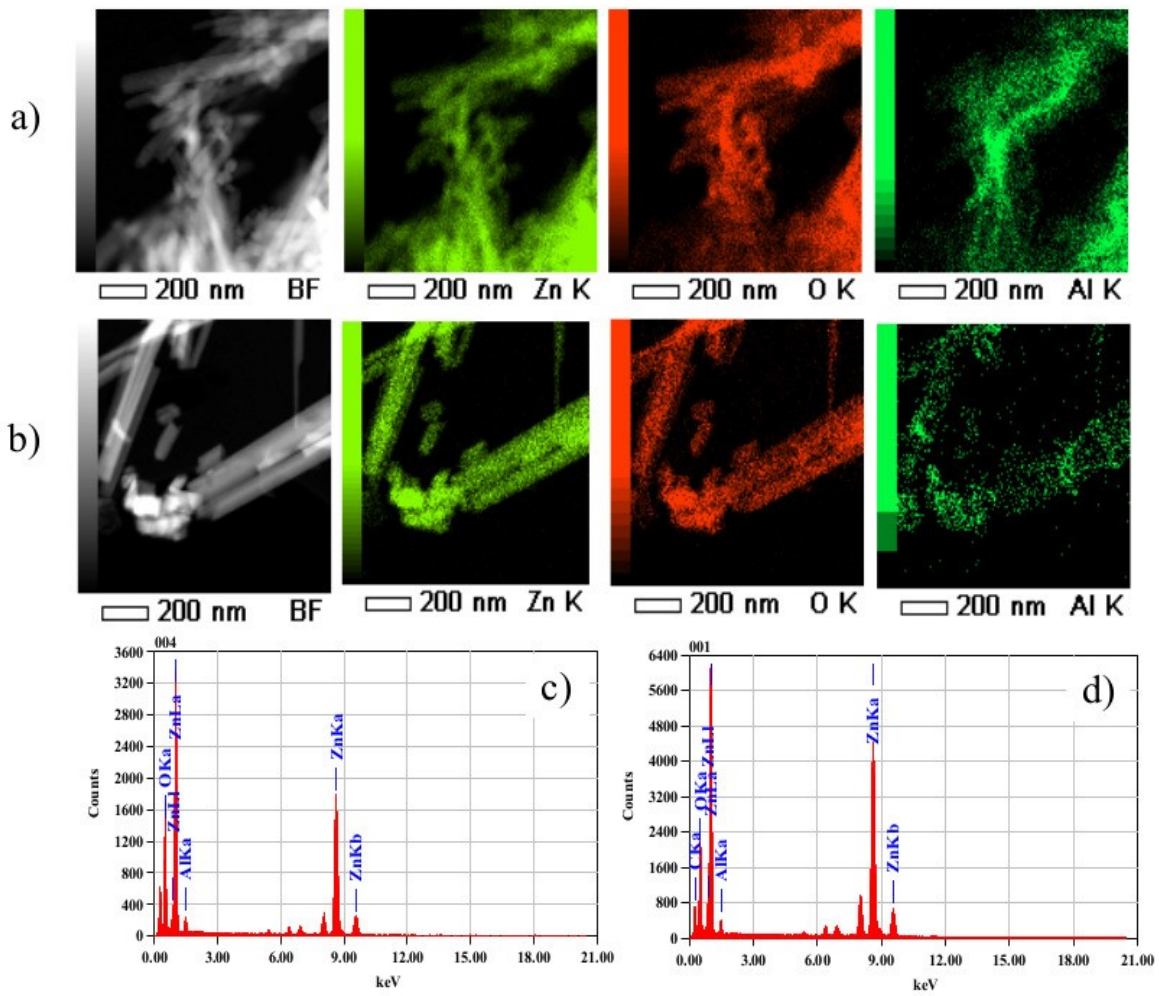
Figure 4. TEM scans and elemental mapping on AZO NRs samples: ( a ) AZO I, ( b ) AZO IV, and the corresponding EDX spectra showing ( c ) AZO I, and ( d ) AZO IV.